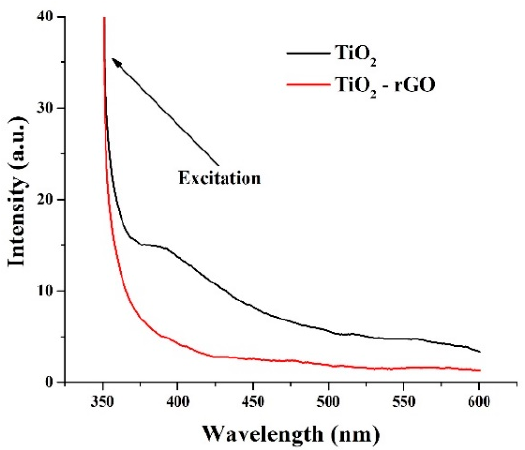
Figure 6. PL analysis of TiO 2 and TiO 2 –rGO films.